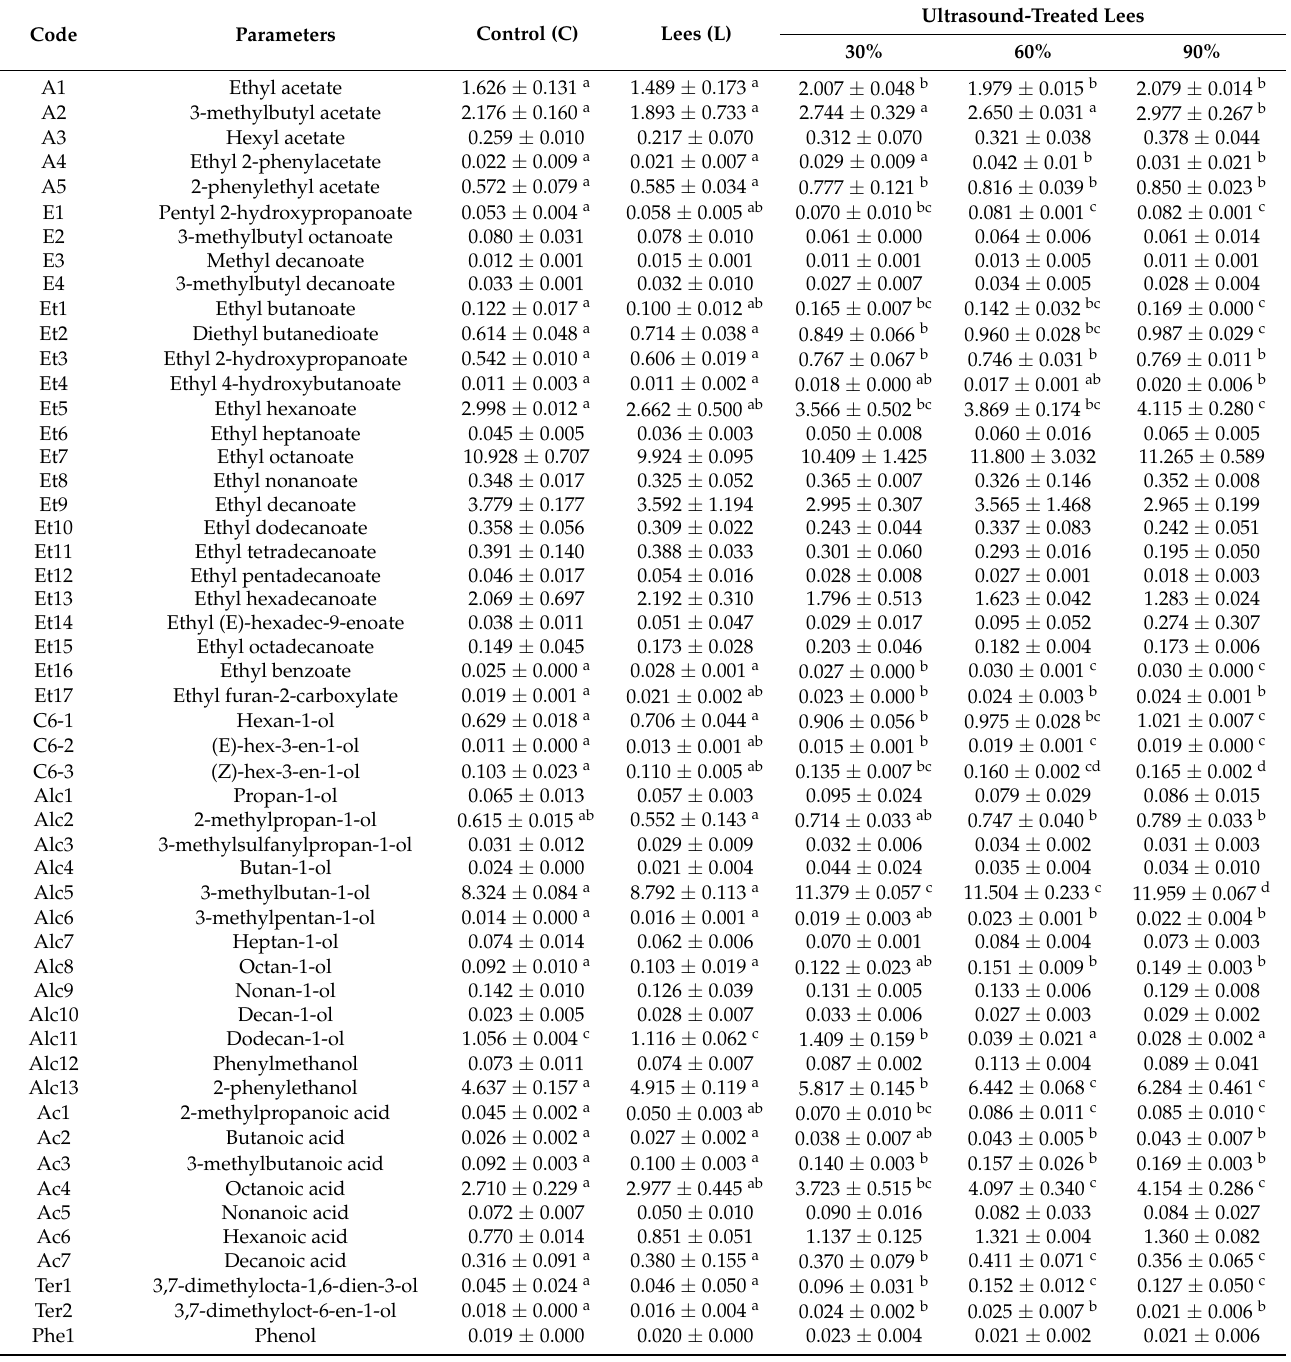
Table 2. Volatile organic compounds (VOCs) (mg/L) of wines aged on ultrasound-treated and untreated lees (different letters indicate significant differences between samples ( p <